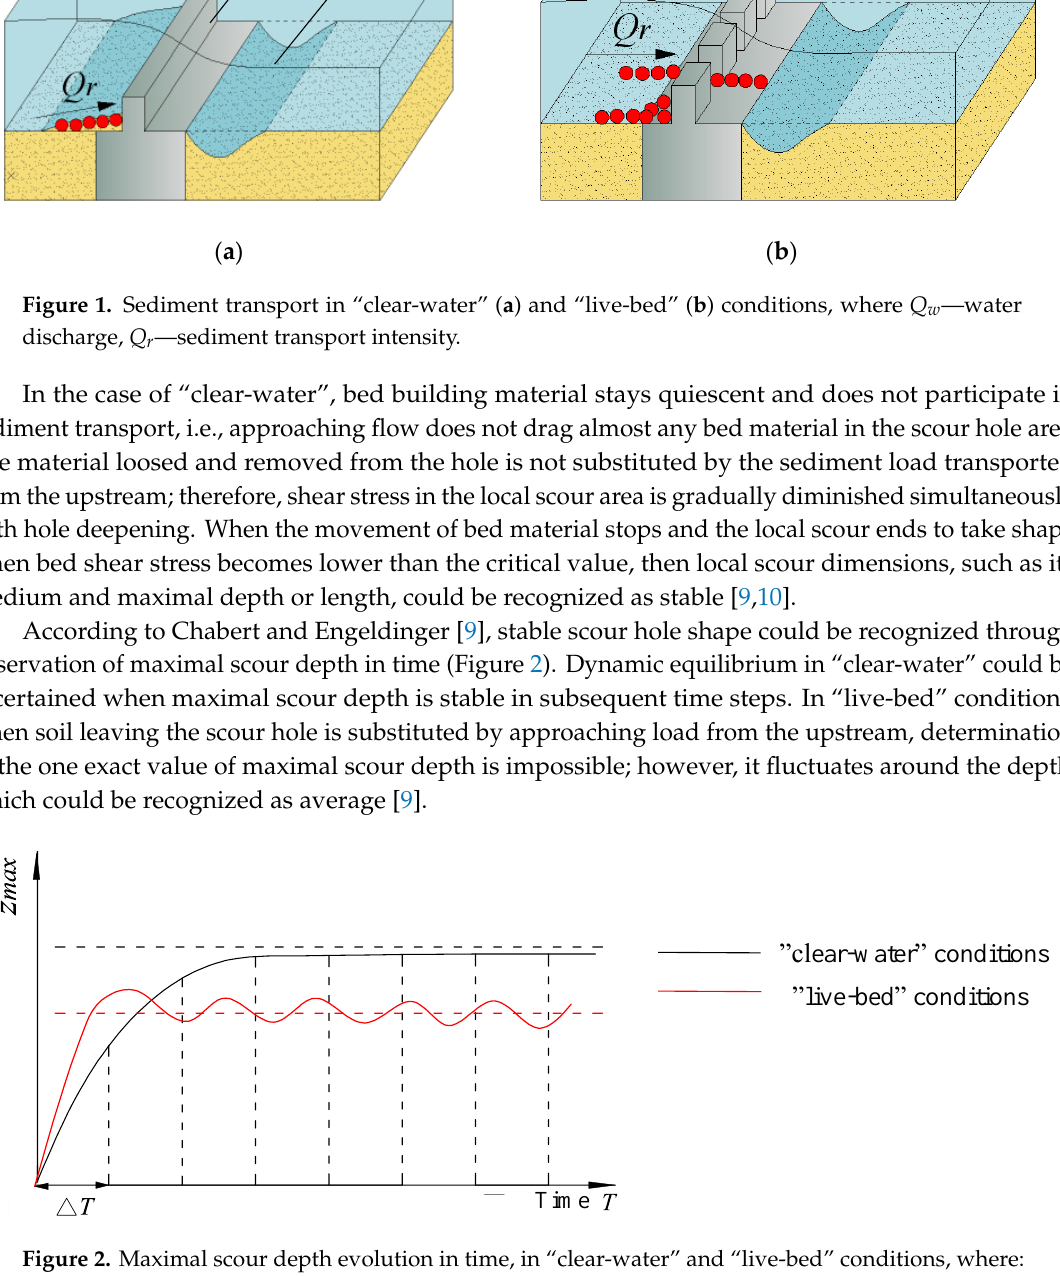
Figure 2. Maximal scour depth evolution in time, in “clear-water” and “live-bed” conditions, where: z max — maximal scour depth, Δ T —time step.